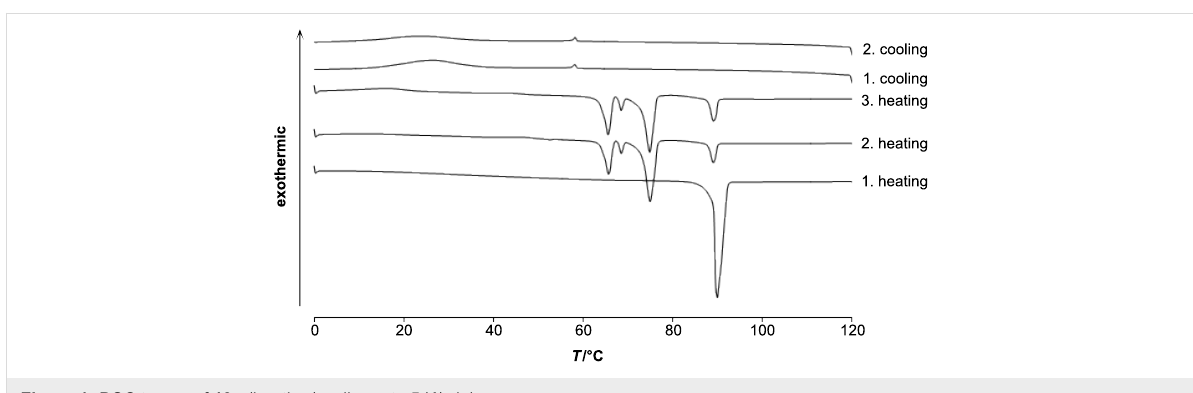
Figure 1: DSC traces of 13a (heating/cooling rate 5 K/min).